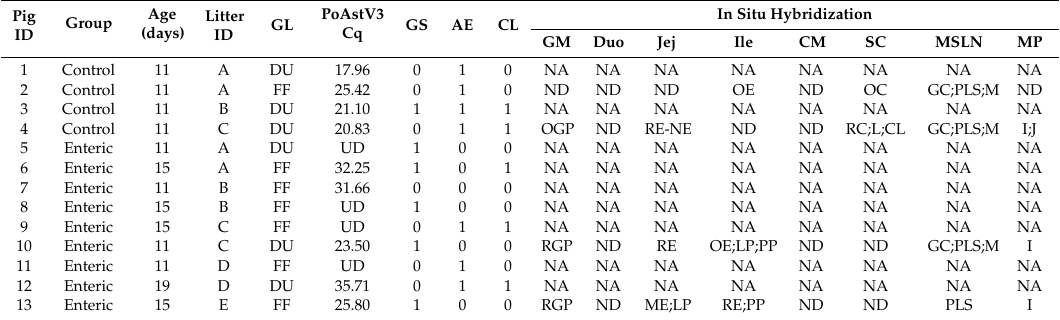
Table 3. Summary of the pathology and RNAscope in situ hybridization of tissues collected from subset of piglets from Sow Farm 1